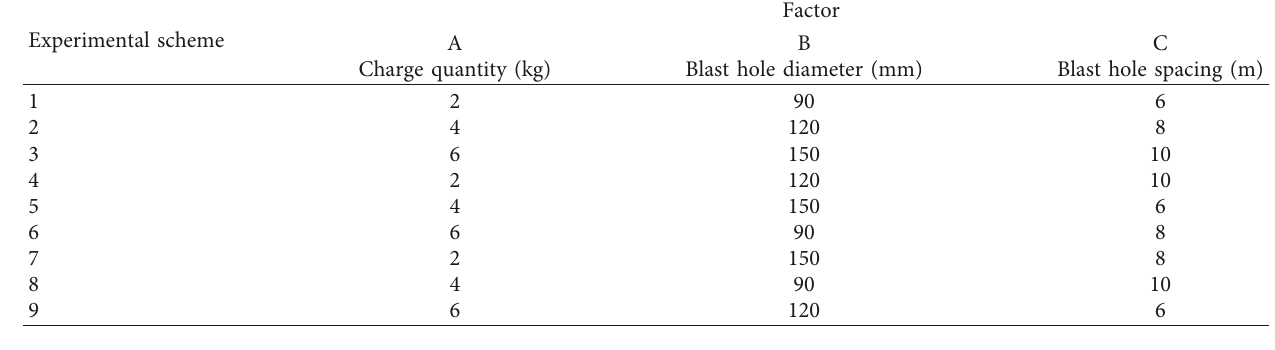
Table 3: Design of factor 3 level test.